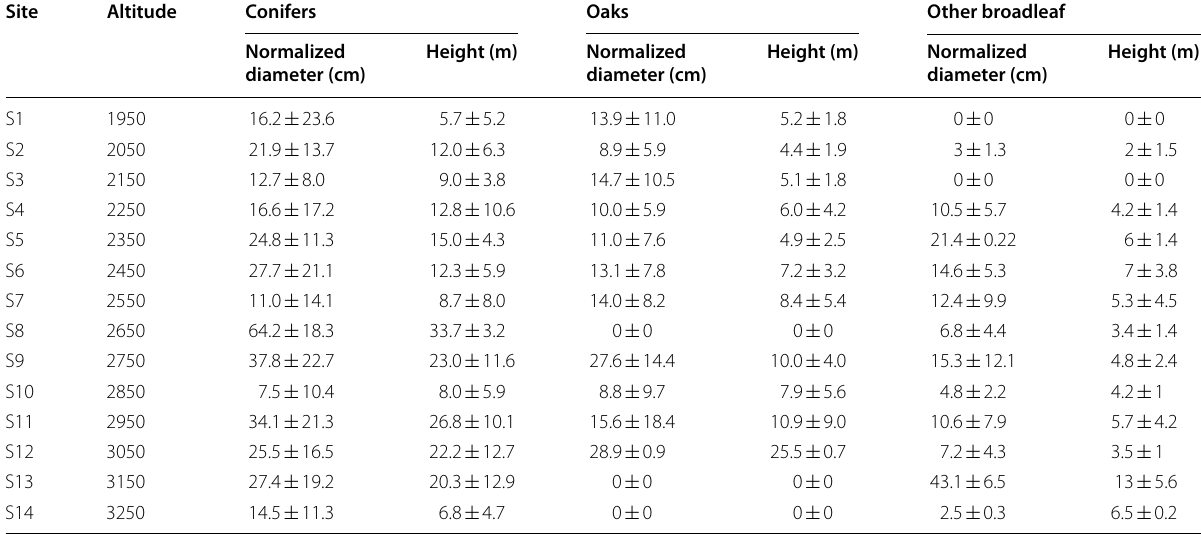
Table 3 Normalized diameters and average heights of conifers, oaks and other broadleaf at each of the sampling sites Site Altitude